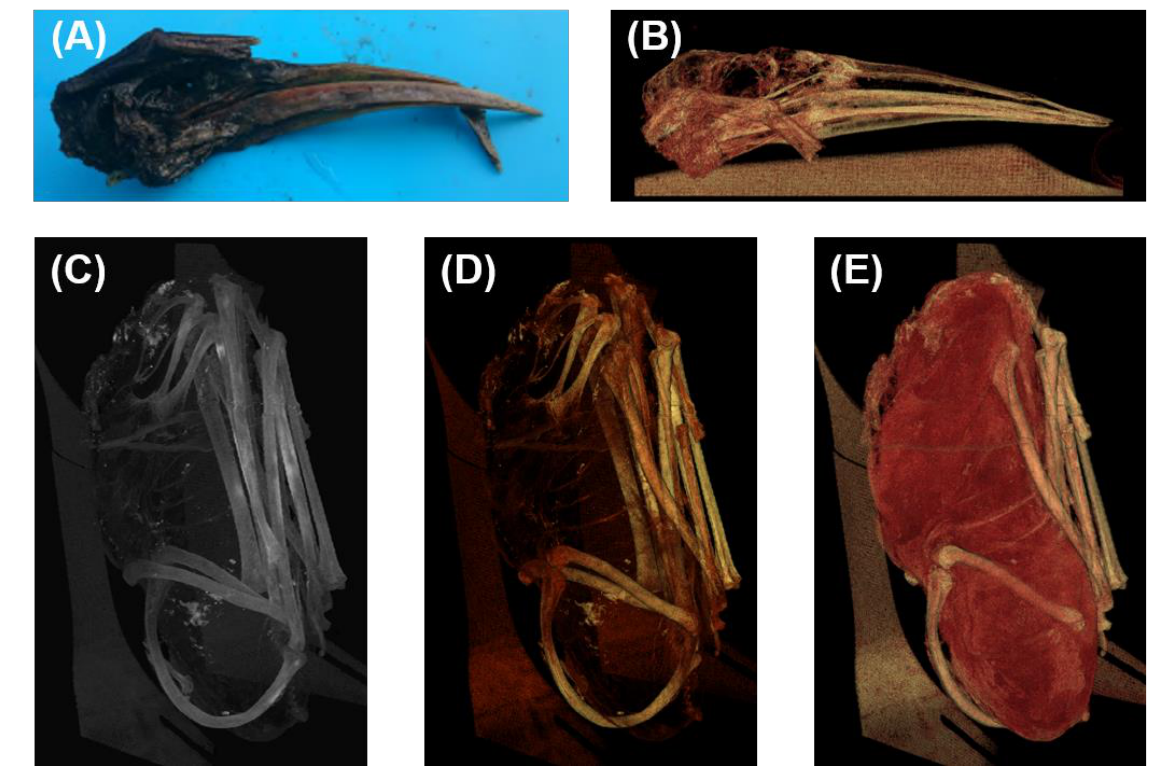
Figure 5. Three-dimensional reconstruction of the skull and the trunk of the Ardea purpurea glacier mummy. ( A ) Photograph of the skull. ( B ) Volume rendering bone of the skull. ( C ) Maximum intensity projection of the body. ( D ) Volume rendering bone of the body. ( E ) Volume rendering soft tissue of the body.